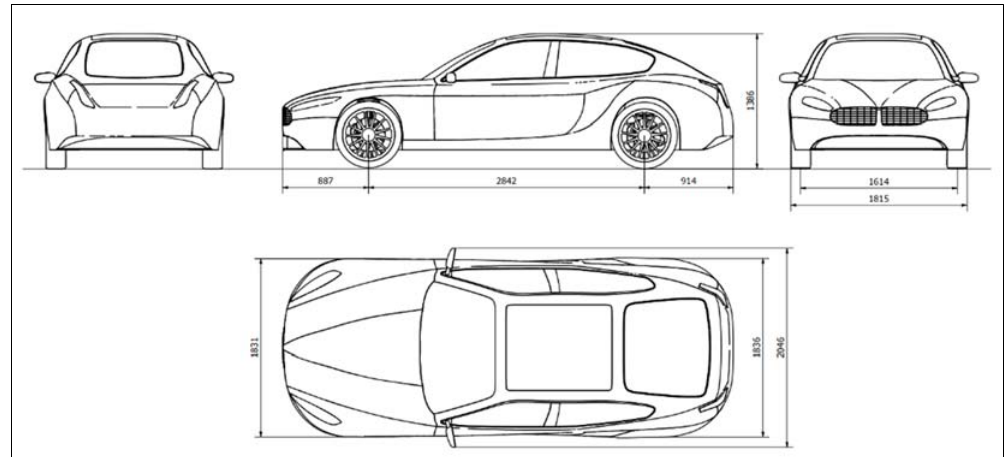
Figure 11. Orthogonal projections of Blitz Vision AS.